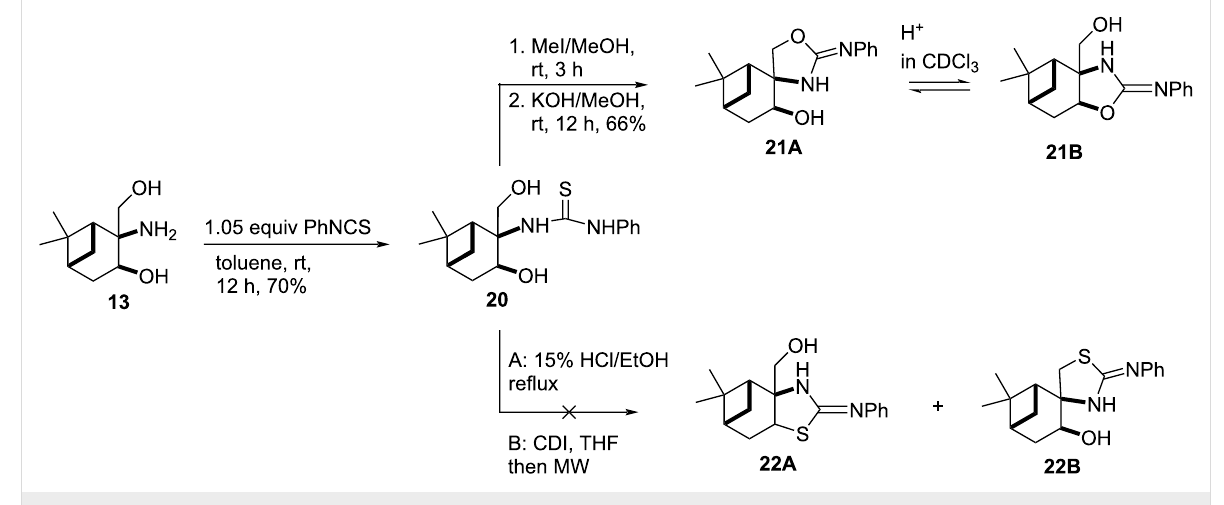
Scheme 6: Synthesis of 2-phenyliminooxazolidines.